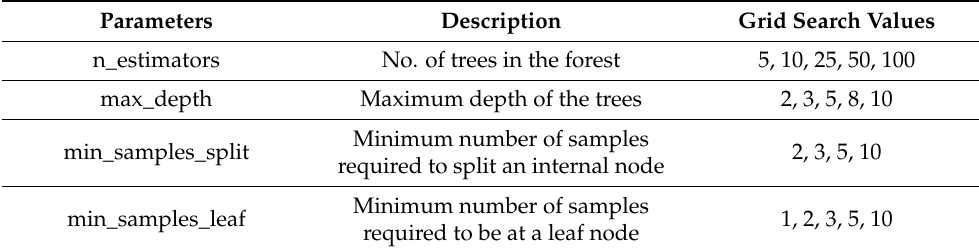
Table 3. Grid Search parameters used in the RF model.